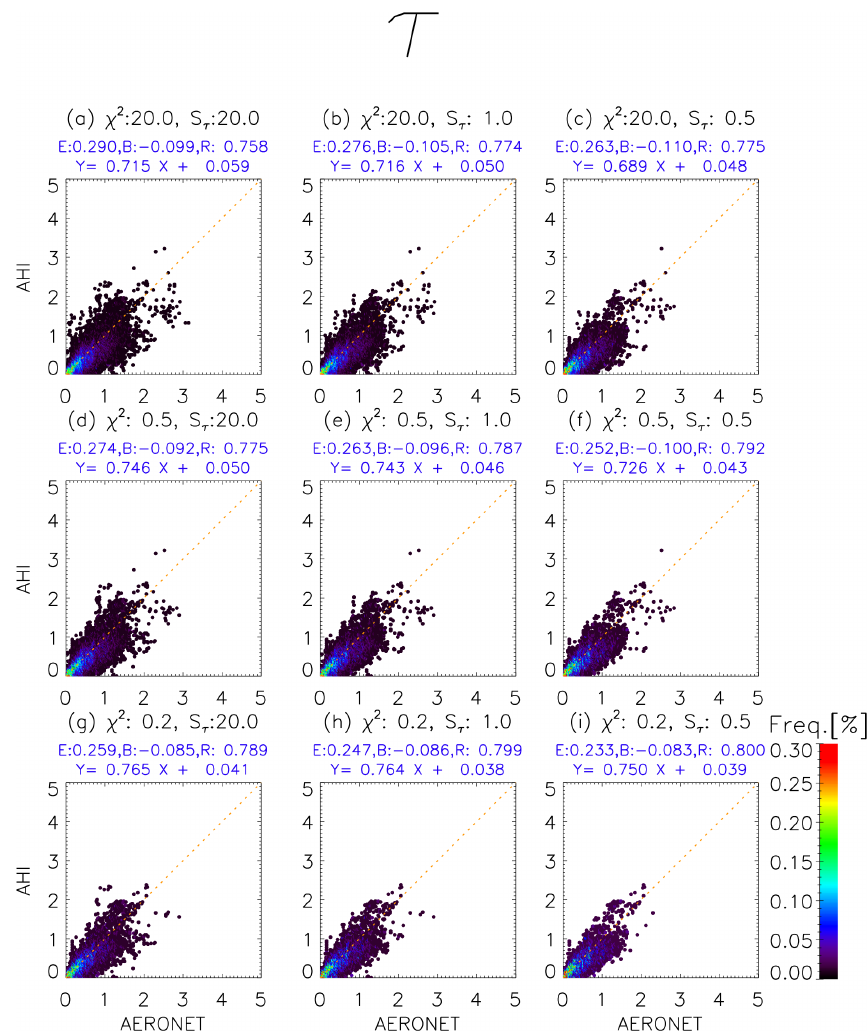
Figure 8. Frequency distribution of τ retrieved from AHI and those from AERONET. The results retrieved from this algorithm in the case of χ 2 less than 20, 0.5, and 0.2 and uncertainties of the retrieved τ ( S τ ) less than 20, 1.0, and 0.5 are plotted in each panel. E , B , and R above the figures show the root mean square error, mean bias, and correlation,